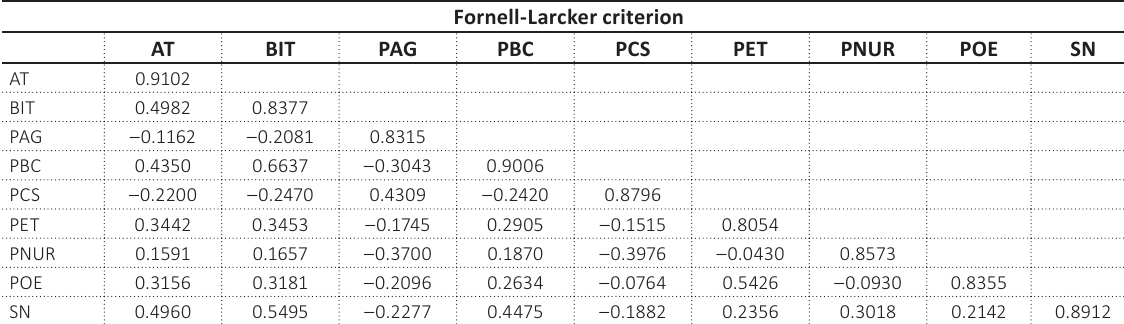
Table 4. Fornell-Larcker criterion test